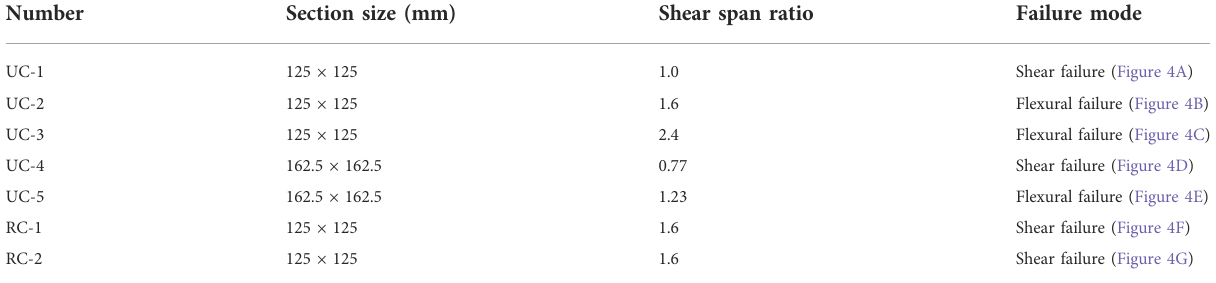
TABLE 5 Failure modes of test